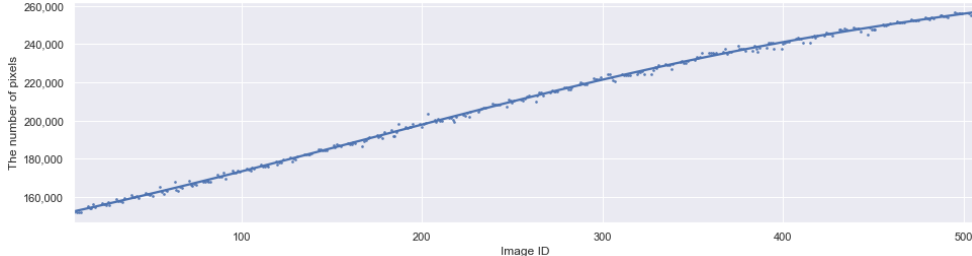
Figure 19. The plot of the modified data and the growth curve made by curve-fitting to 5th degree polynomials, with Seaborn